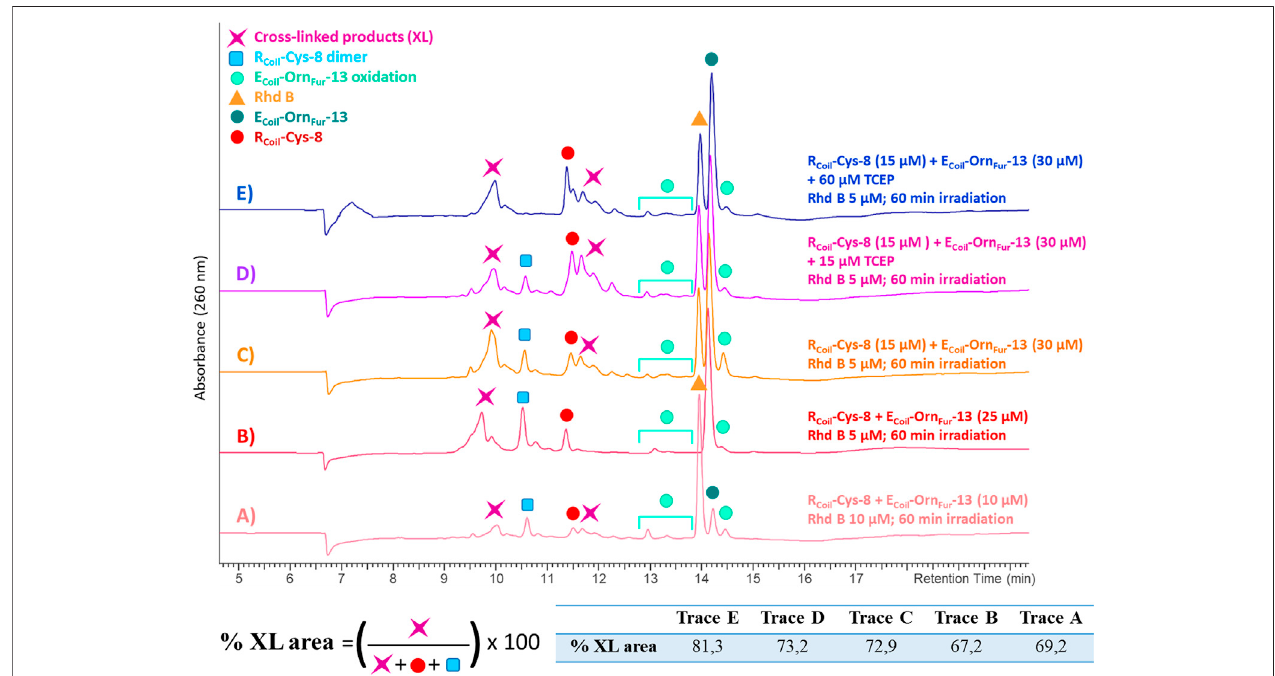
FIGURE 8 | All the chromatograms show the cross-linking reaction product (purple star) between R Coil -Cys-8 (red dot) and E Coil -Orn Fur -13 (dark green dot) after light irradiation with Rhd B (orange triangle). The E Coil -Orn Fur -13 oxidation products (green light dots) are produced after activation of the furan moiety by singlet oxygen generation. (A) R Coil -Cys-8 (10 μ M) andE Coil -Orn Fur -13(10 μ M),RhdB10 μ M and60 minoflightirradiation. (B) R Coil -Cys-8 (25 μ M) and E Coil -Orn Fur -13(25 μ M),RhdB 5 μ Mand60 minoflightirradiation. (C) R Coil -Cys-8(15 μ M)andE Coil -Orn Fur -13(30 μ M),RhdB5 μ Mand60 minoflightirradiation. (D) R Coil -Cys-8(15 μ M)+15 μ